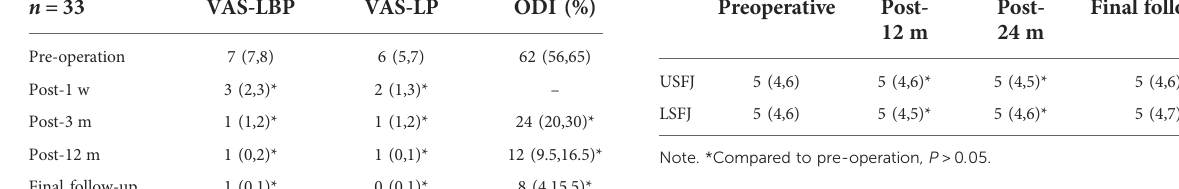
TABLE 2 Comparison of indicators related to ef fi cacy evaluation before and after PE-TLIF. n = 33